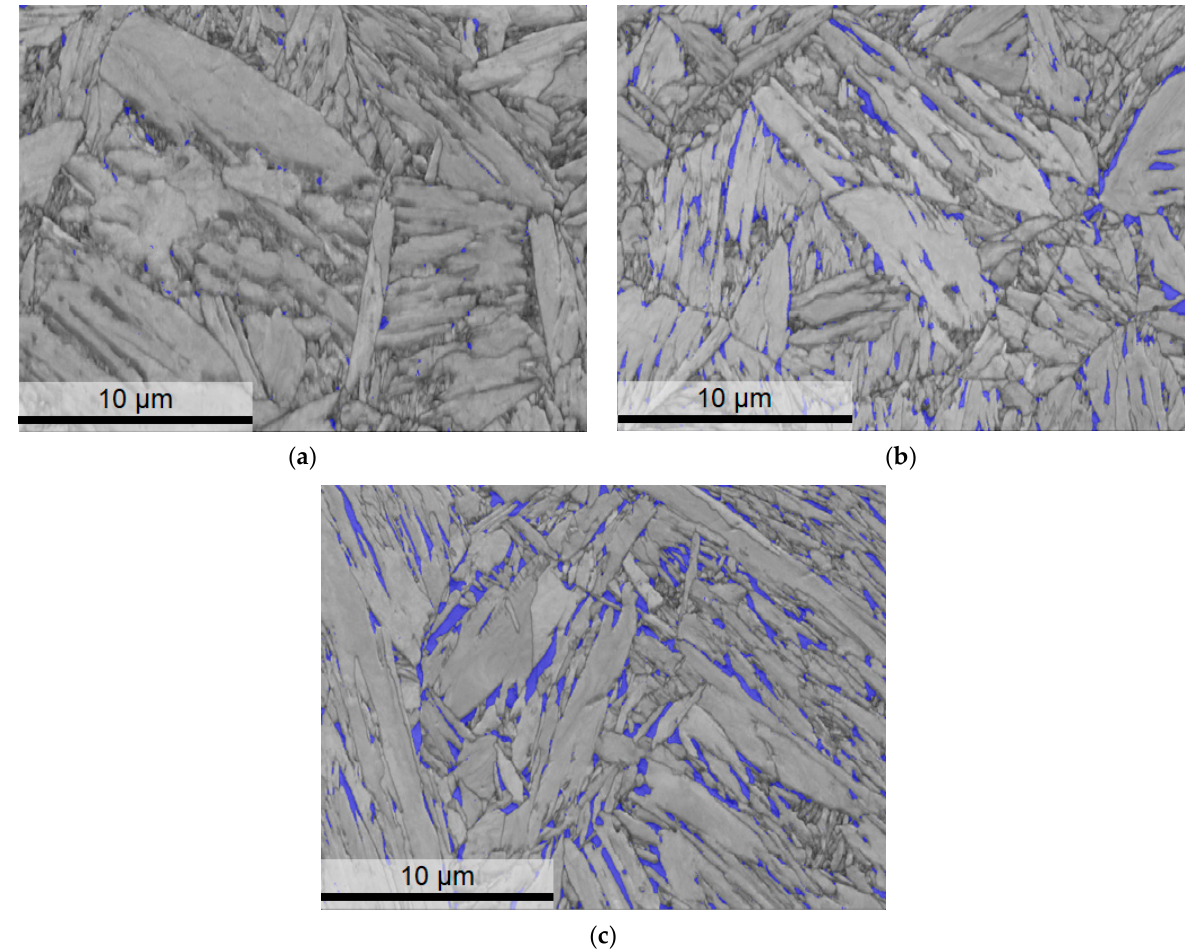
Figure 9. EBSD image quality (IQ) and phase maps after the current QP process. ( a ) QP-321, ( b ) QP-371, ( c ) QP-421. Blue corresponds to areas identified as retained austenite (RA). Table 3. Volume fraction of retained austenite measured by EBSD and XRD.